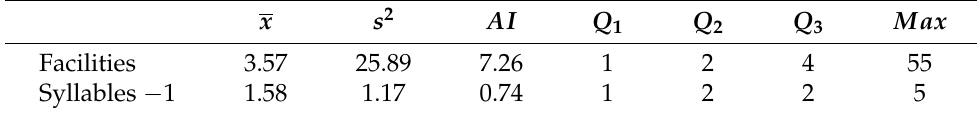
Table 4. Descriptive statistics for data in examples.